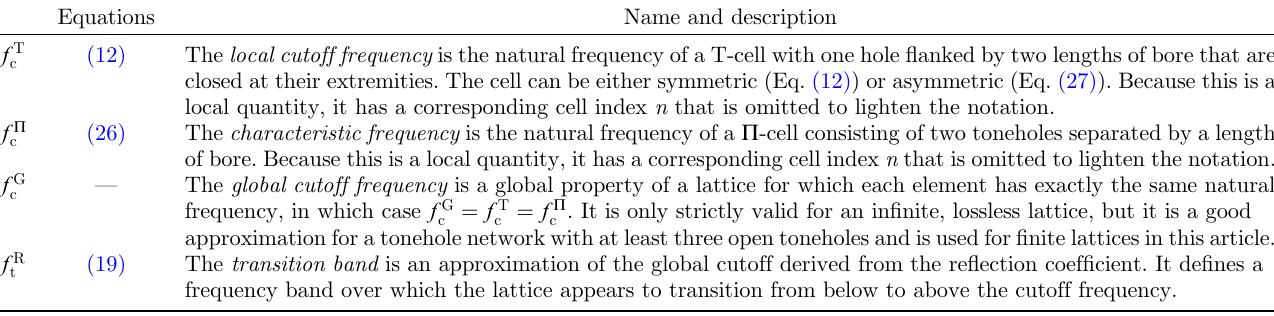
Table 1. Summary of the different types of cutoff frequencies used in the current article.